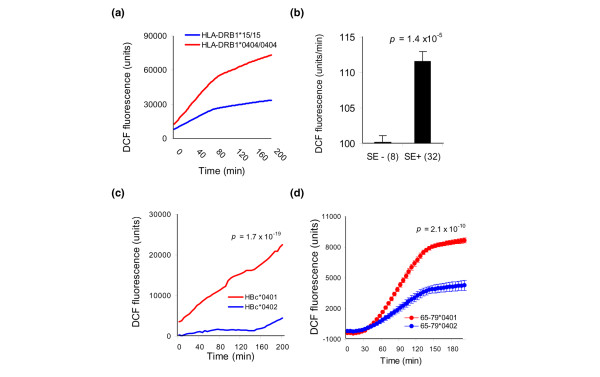
The shared epitope (SE) accelerates endogenous reactive oxygen species (ROS) production. (a) Time-course ROS levels in representative SE-positive (red line) and SE-negative (blue line) B-lymphocyte cell lines. (b) ROS production rates in B lymphocytes. Results are shown as the mean ± standard error of the mean fluorescent units per minute (FU/minute) during the linear late phase of the ROS curve (80 to 200 minutes). Data of the SE-positive (SE+) and SE-negative (SE-) groups were compiled from three to five consecutive experiments in each cell line. The values in parentheses represent the number of donors in each group. (c) ROS levels in M1 cells stimulated with 2.5 μg/ml of either SE-positive hepatitis B core (HBc) capsids (HBc*0401, red line) or SE-negative HBc capsids (HBc*0402, blue line). (d) ROS levels in M1 cells stimulated with 100 μg/ml of either an SE-positive 15 mer peptide (65–79*0401, red circles) or an SE-negative 15 mer peptide (65–79*0402, blue circles). Calculations of p values in (c) and (d) were based on paired t test analysis. DCF, dichlorofluorescein.